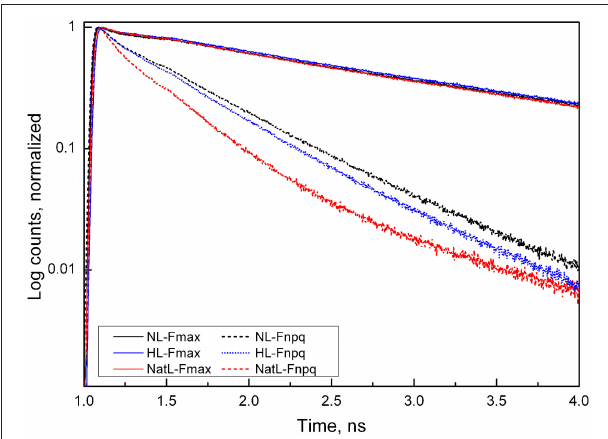
FIGURE 6 | Normalized fluorescence decays in Arabidopsis leaves. Fluorescence decay was measured in either unquenched dark-acclimated state (Fmax) or in the quenched light-acclimated state (F NPQ ). The excitation wavelength was 663 nm and the emissions measured at 683nm. The faster decay in the F NPQ state indicates the activation of fluorescence quenching. Note that plants grown under NatL conditions exhibited the strongest quenching.